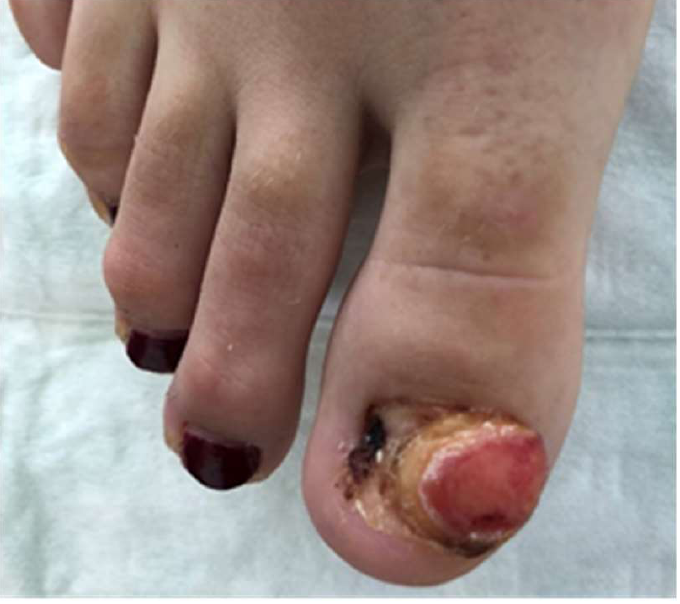
Figure 1. Ulcerated erythematous nodule covering the majority of the nail bed of the right big toe. It measured approximately 20 × 20 mm. At this stage a SE was suspected, and a plain X-ray showed a significant exostosis arising from the distal phalanx of the toe (Figure 2). The lesion was shaved and sent for histology and a second specimen was taken from the bone at the deep margin of the lesion. The histology showed a reactive myofibroblastic proliferation with a myxoid stroma and focal areas of keloidal-like collagen overlying mature cartilage and bone fully in keeping with a SE (Figure 3A–D). The deep specimen showed fragments